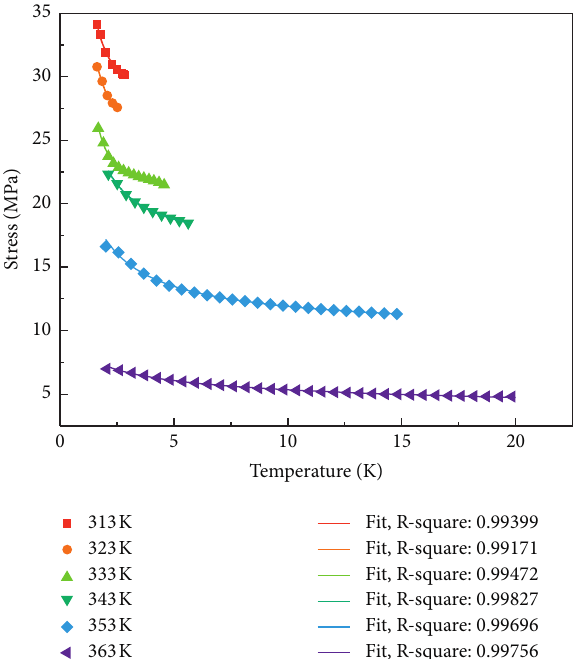
Figure 6: Fitting result of stress in the strain softening stage at different